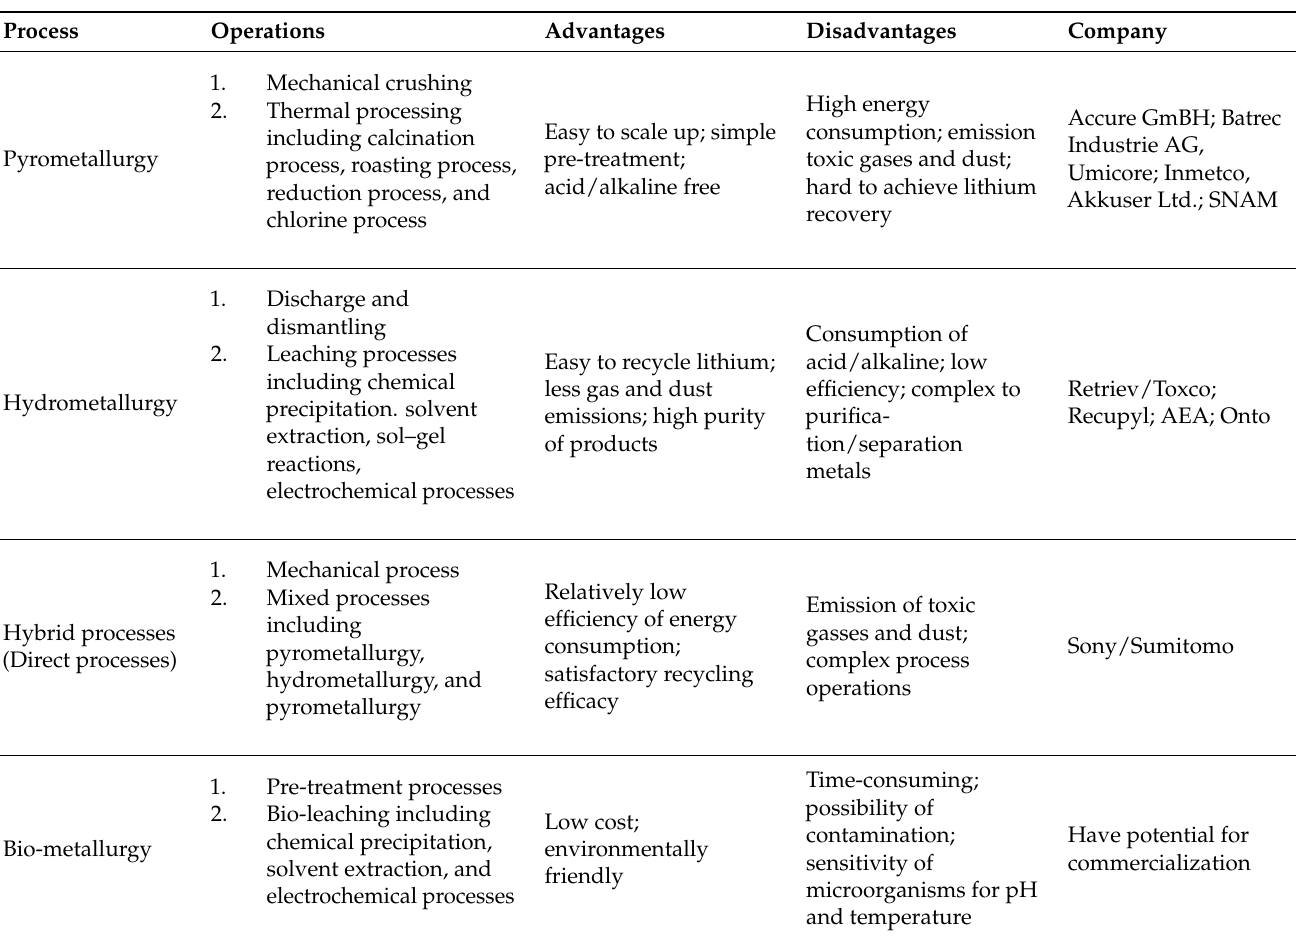
Table 6. Comparison of different processes for recycling spent LIBs